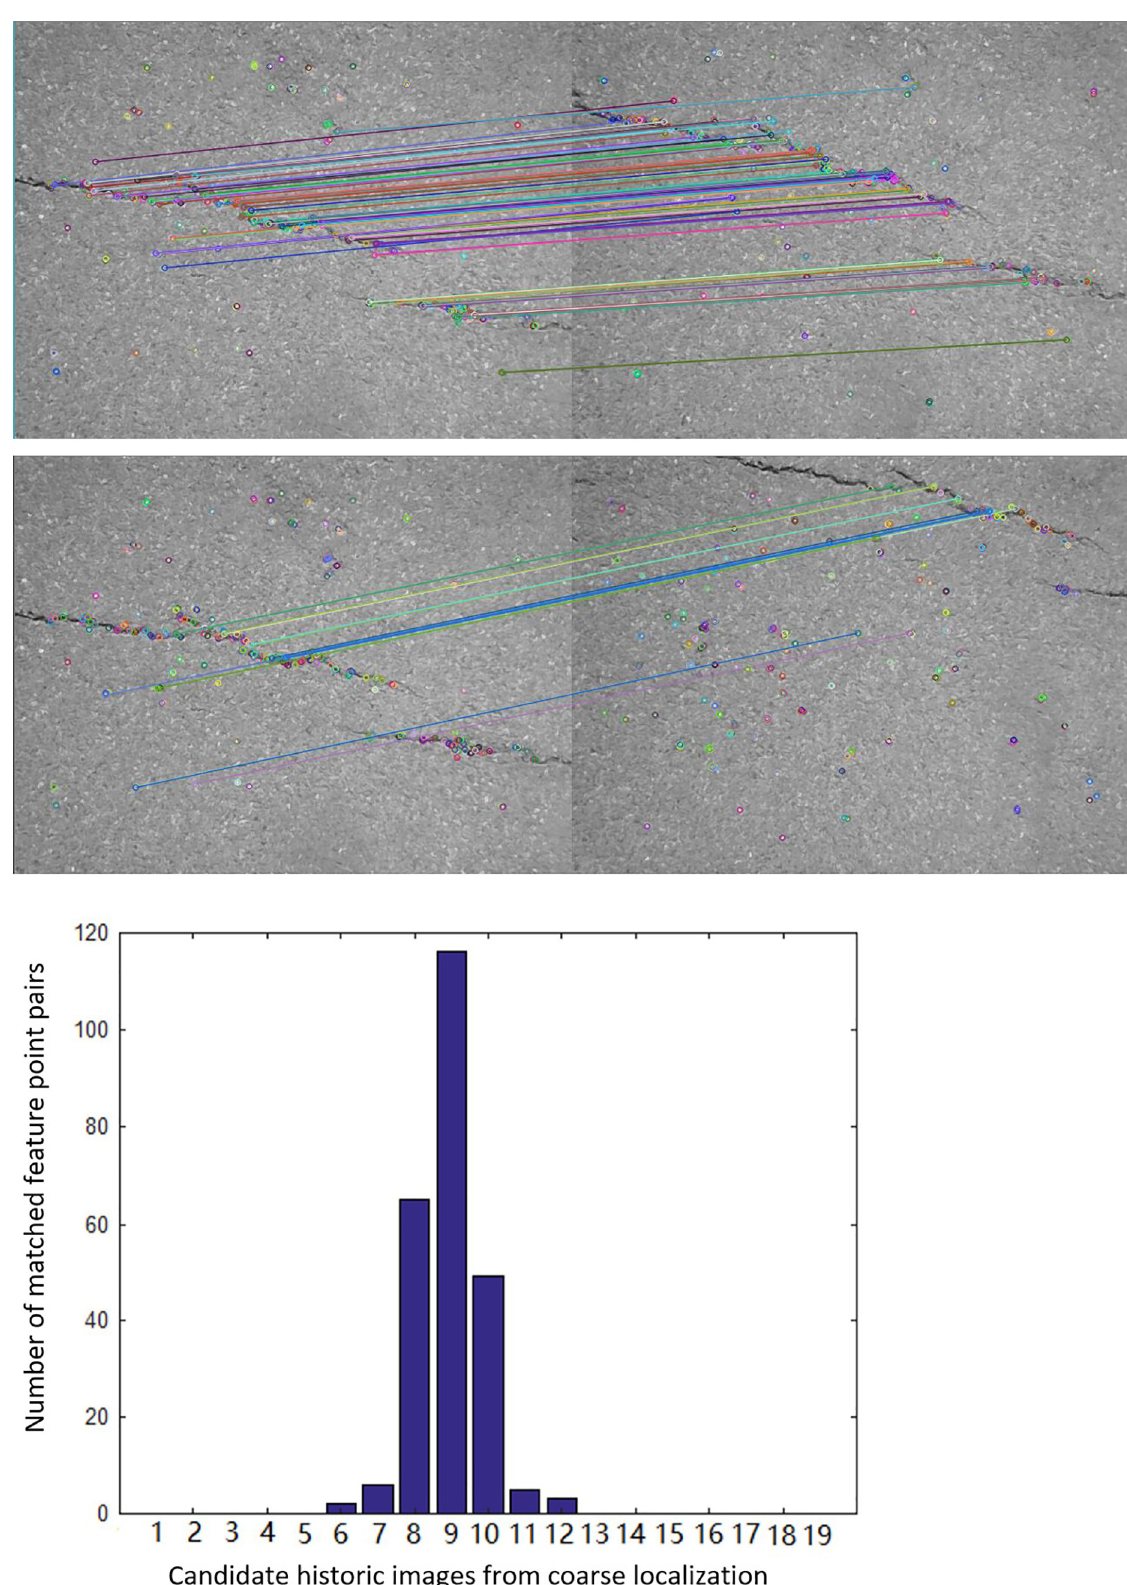
Fig 9. The local feature point pairs for query crack image and candidate historical crack images. https://doi.org/10.1371/journal.pone.0235171.g009 PLOS ONE | https://doi.org/10.1371/journal.pone.0235171 August 14,